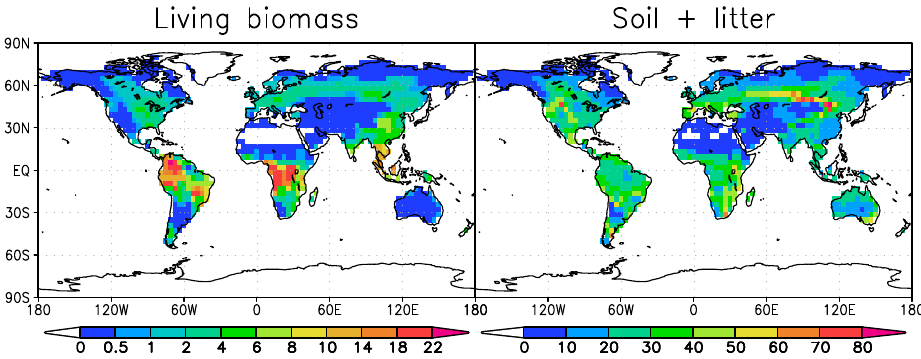
Fig. 2. Carbon storages in kg/m 2 for different pools of the control run.